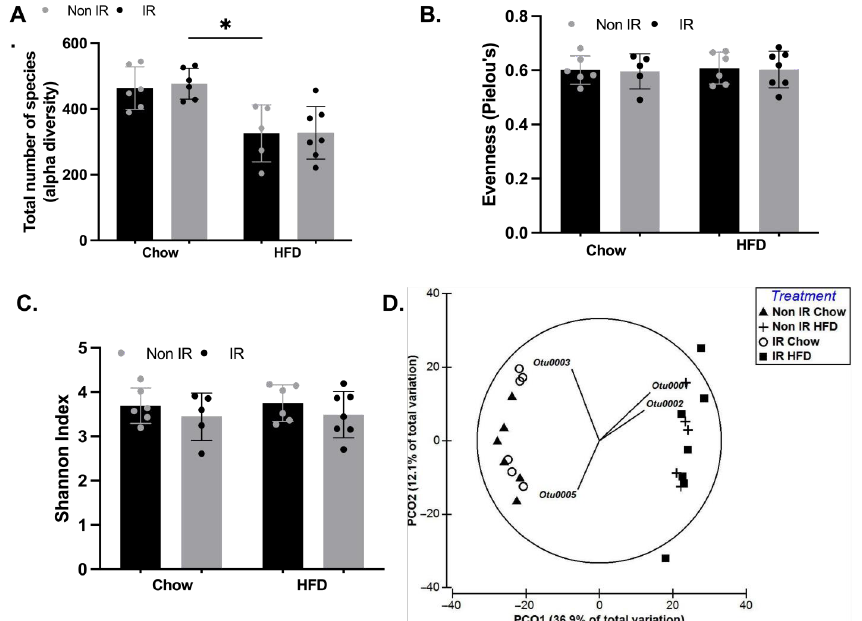
Figure 5. The effect of irradiation and diet on the gut microbiota diversity of mice. ( A ). Total number of OTUs; ( B ). Pielou’s evenness : intra-sample difference in relative abundance of OTUs; ( C ). Shannon index; ( D ). Principal-coordinate analysis (PCoA) of a Bray – Curtis resemblance matrix generated from square-root-transformed data with vectors generated by multiple correlations (>0.4). Non IR — Non-irradiated; IR — Irradiated; Chow = chow diet; HFD — High-fat diet. * = p < 0.05. In panels ( A – C ), black bars and grey dots represent non-irradiated mice; grey bars and black dots represent irradiated mice.